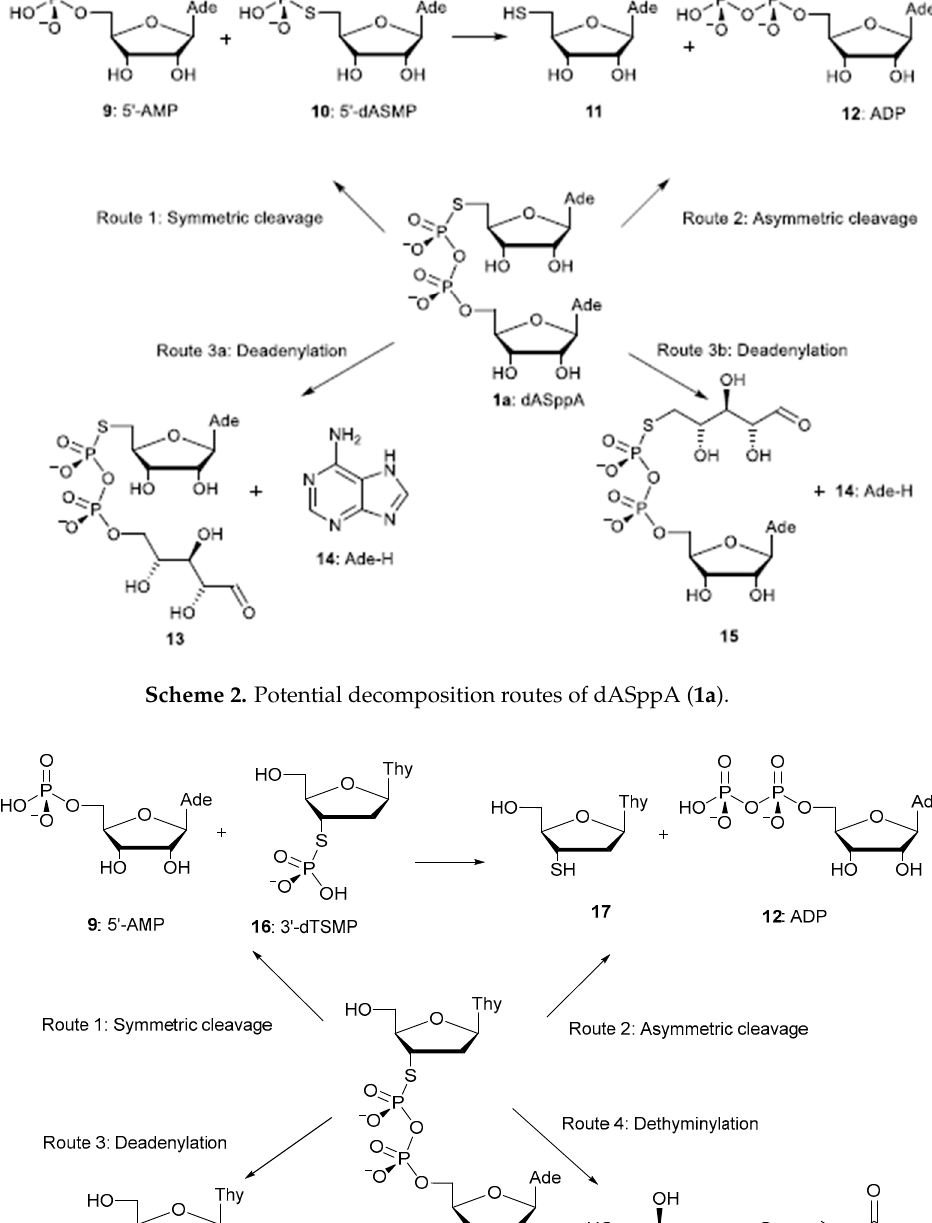
Table 1. Rate constant for the hydrolysis of nucleotides under acidic, neutral and alkaline condi-